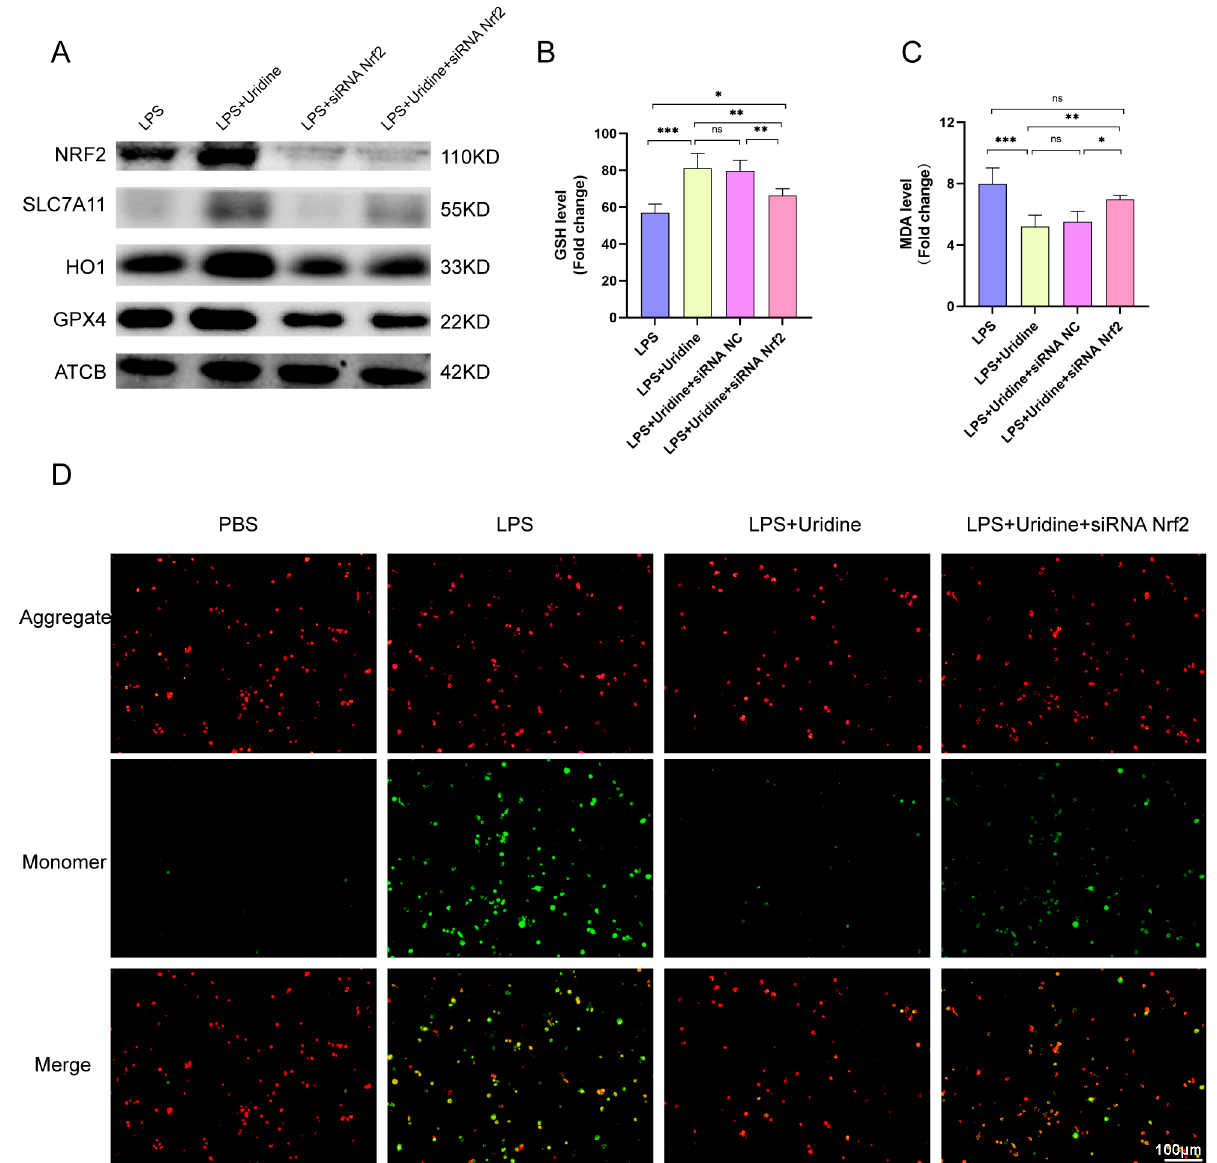
Figure 6. Nrf2 knockdown via siRNA abrogated the antioxidative effect of uridine. ( A ) Western blots for Nrf2, HO1, SLC7A11 and GPX4 protein of THP-1 cells in the indicated group. ( B , C ) Relative GSH and MDA levels in the indicated group. NC means negative control. ( D ) Representative images of fluorescence probe for mitochondrial membrane potential determined by JC-1. n = 6 per group. (Data are presented as Mean ± SD, * p < 0.05, ** p < 0.01, *** p < 0.001 compared with indicated group).